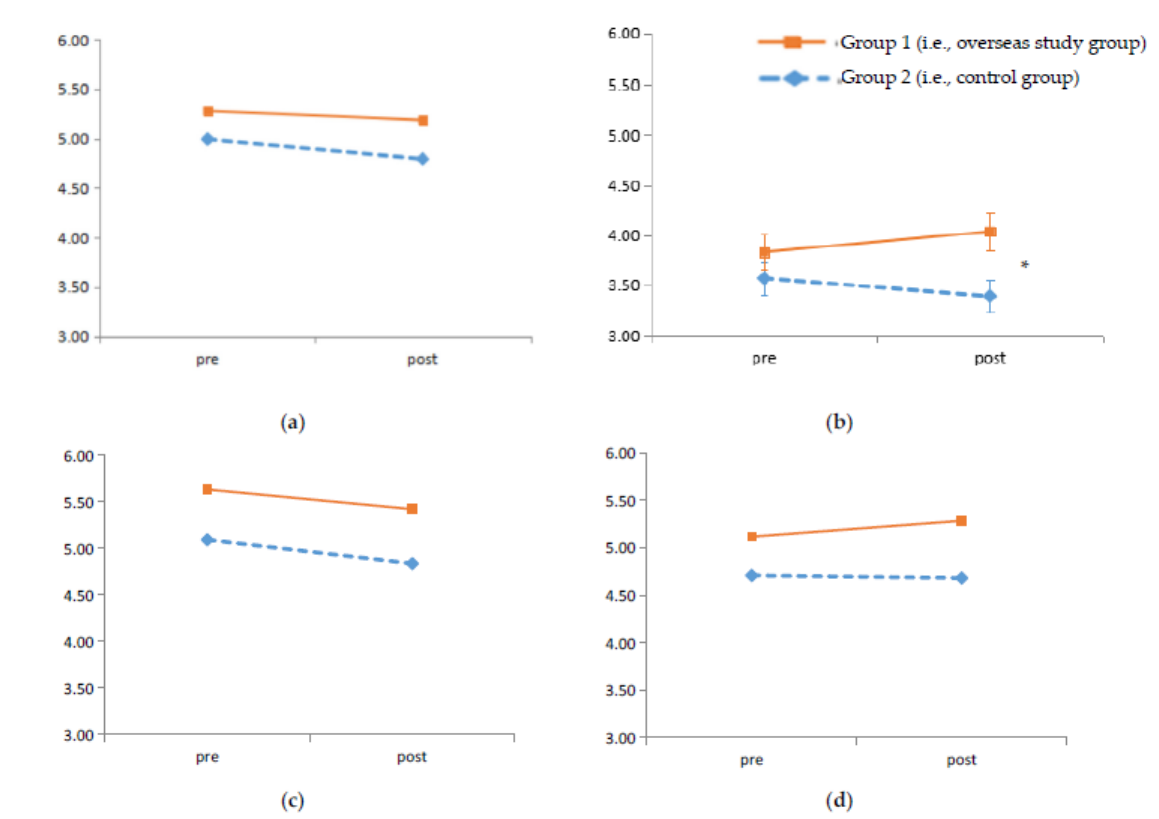
Figure 1. Levels of cultural competence in pre- and post-test. The time interval between the pre- and post-test was about 10 weeks. Error bars represent ± 1 SE. * indicates a significant interaction effect ( p < 0.05). ( a ) Metacognitive aspects: cultural awareness; ( b ) Cognitive aspects: cultural knowledge; ( c ) Motivational aspects: cultural attitude; ( d ) Behavioural aspects: cultural skills.